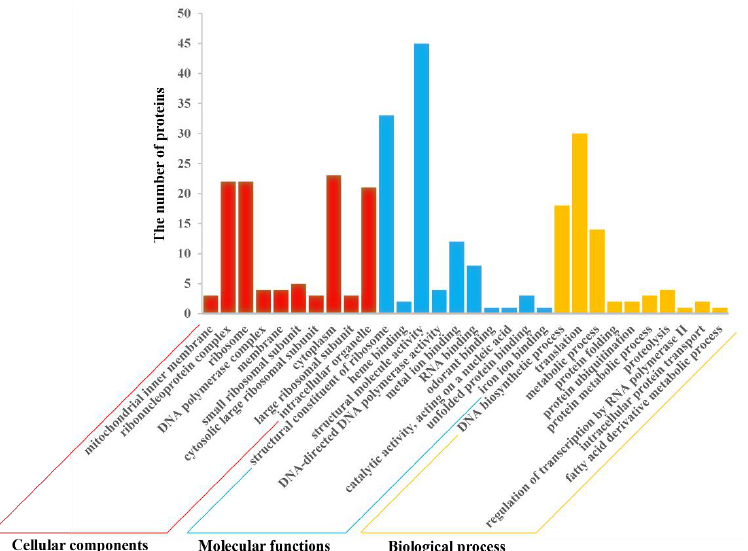
Figure 9. Differential expressed proteins classified based on known cellular components, biological processes, and molecular functions.